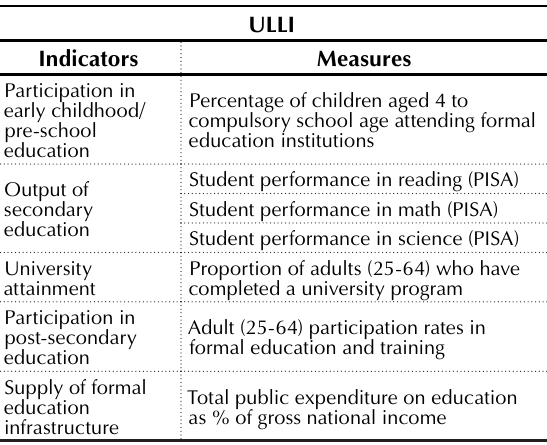
Table 2. The adapted dimension of learning to